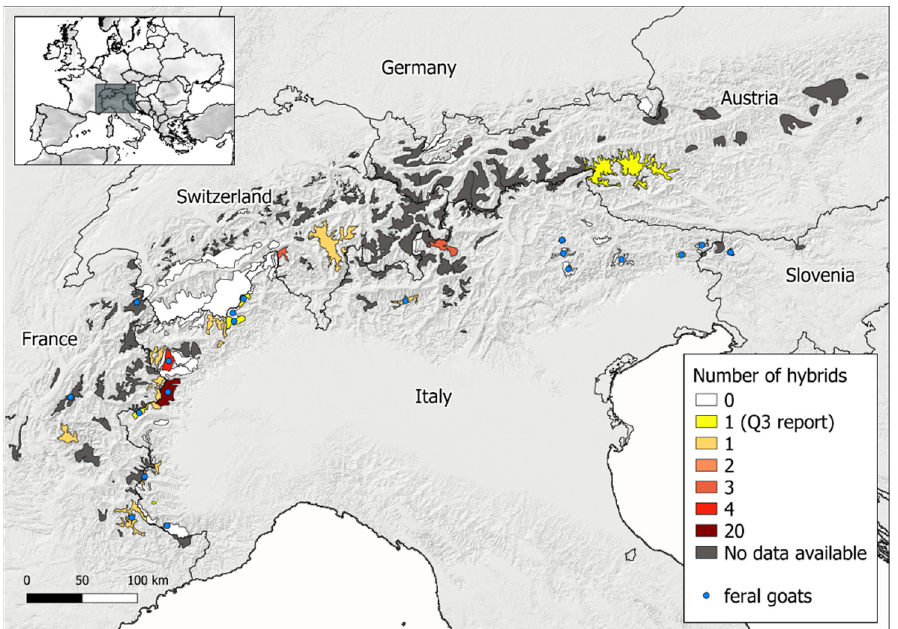
Figure 2. Distribution and abundance of the probable hybrids observed between 2000 and 2021 in the Alps, and the localization of the feral goats observed in the same areas. The map includes the colonies of Alpine ibex (data originally from [32], also included in the IUCN Red List of Threatened Species [12]) colored according to the number of hybrids observed. The orange to dark-red gradient represents colonies with a number of hybrids reported between 1 and 20 (with reports of quality Q1 and Q2). The yellow polygons represent colonies for which a single report of a probable hybrid was received, but the quality of the report was low (Q3: reports coming from reliable local experts, but with no or low-quality visual documentation available). The white polygons represent colonies where no hybrids were reported (negative reports), while the dark grey polygons represent colonies for which no reports were available (neither of the presence nor absence of hybrids). Alpine ibex colonies where feral domestic goats were also observed are represented with a blue